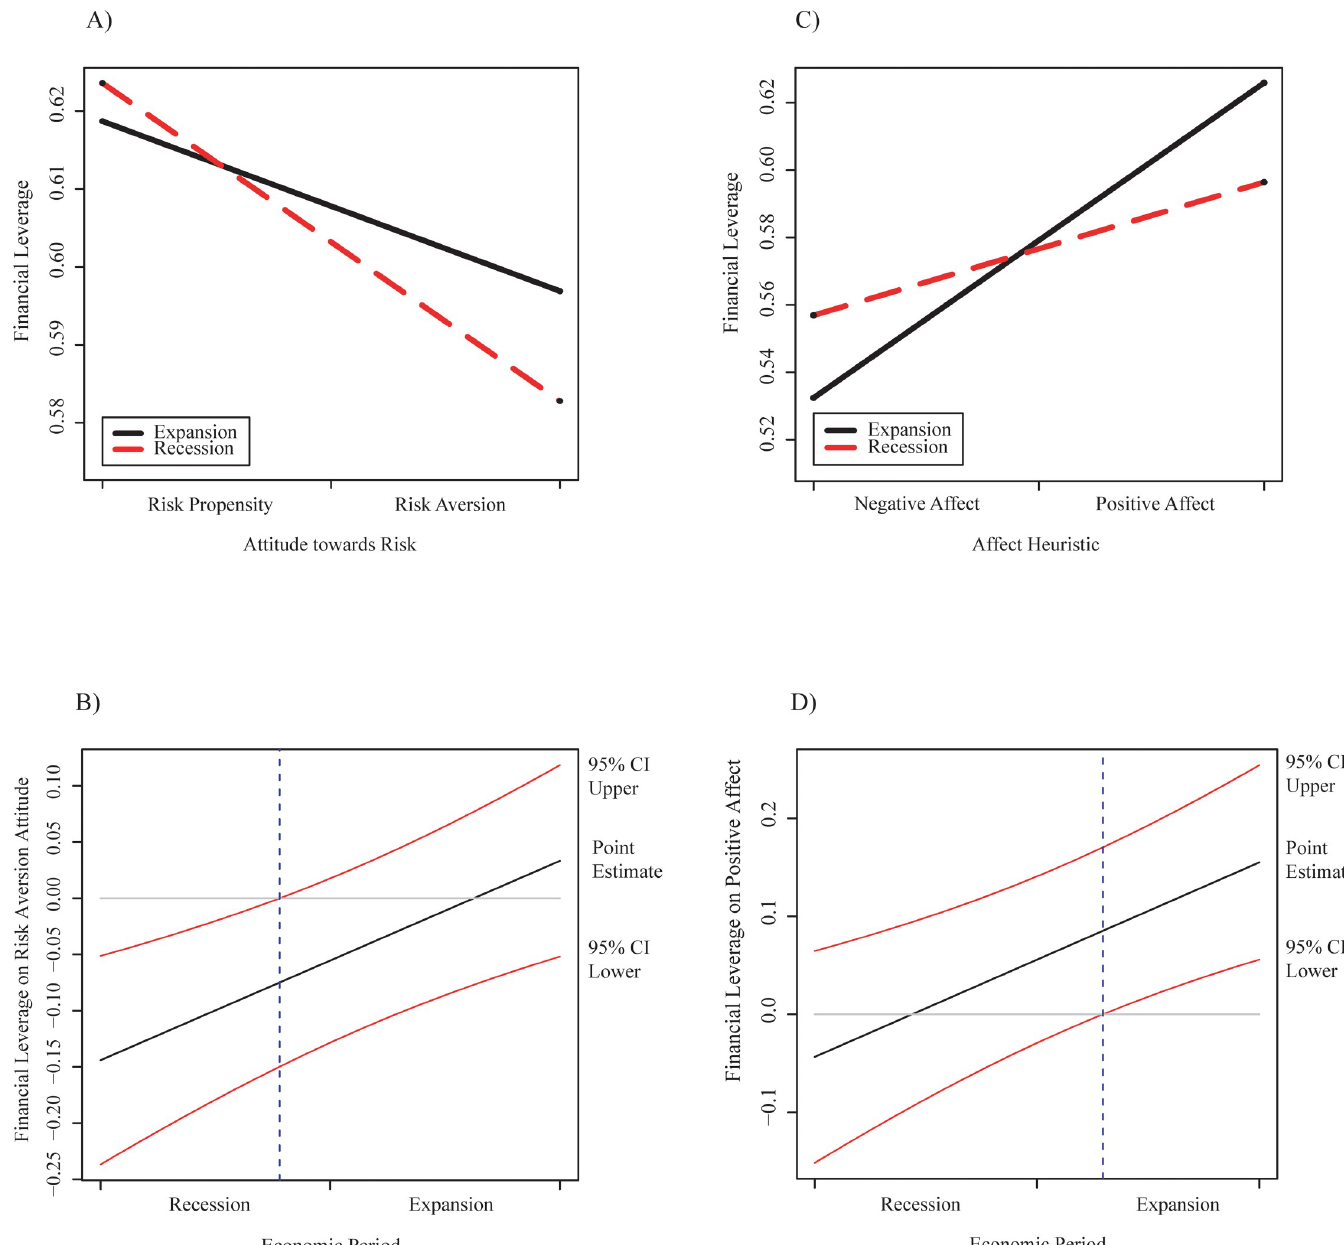
Fig 1. Interactions and confidence intervals graphs of the relation of traits and financial leverage. A) Graph of simple slopes of risk attitude of CEOs on total debt in function of the economic situation. B) Confidence intervals of risk attitude of CEOs on total debt for the two economic periods. C) Graph of simple slopes of affect heuristic on total debt in function of the economic situation. D) Confidence intervals of positive affect heuristic of CEOs on total debt for the two economic periods.